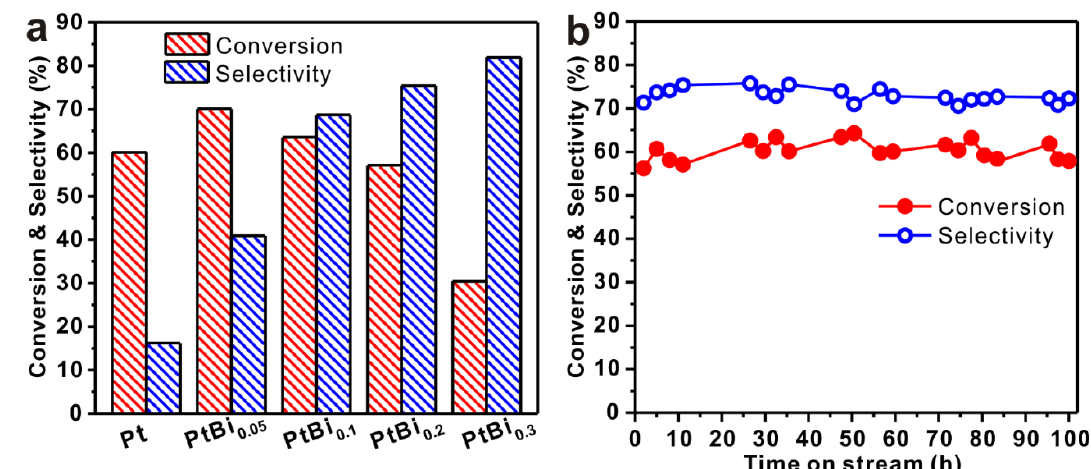
Figure 6. ( a ) Catalytic performances of Pt/SiO 2 and PtBi x /SiO 2 in gas-phase ODH of KA-oil (mass ratio of alcohol and ketone is 1:1). ( b ) Long-term stability test of PtBi 0.2 /SiO 2 catalyst. Reaction conditions: 180 °C, 0.2 g catalyst mixed with 1.2 g quartz sand, air = 16 mL min − 1 , KA-oil = 0.4 mL h − 1 . The carbon balance is >95%.